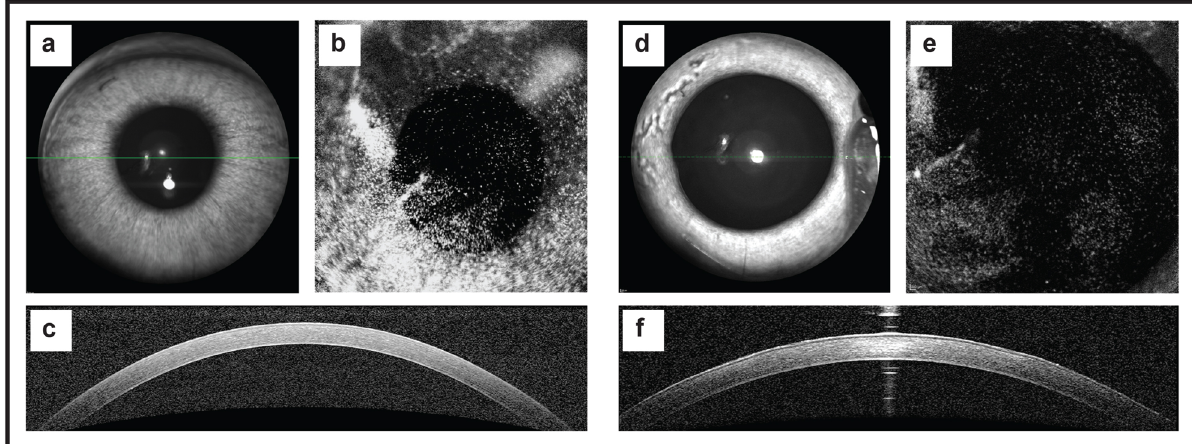
Figure 3. The effect of DIR on rabbit corneal endothelium following intracameral injection in vivo. DIR (final concentration 100 µg/ml) was injected into the anterior chamber of 3 rabbits to determine if this had any side- effects. ( a ) Photomicrograph of the rabbit anterior segment taken 1 day post DIR intracameral injection. The cornea remains transparent, with easy visualization of the iris details. ( b ) Infra-imaging using, the ICG filters on the Spectralis HRA, shows variable fluorescence across the endothelium, with speckled hyperfluorescent seen at areas of increased cellular dye uptake. ( c ) OCT image showing an optical cross-section of the central rabbit cornea. No increase in corneal thickness or inflammation is seen (CCT. Images from the same rabbit cornea taken on day 28 post DIR injection. ( d ) A photomicrograph of the rabbit anterior segment showing the cornea remains clear. ( e ) Infra-imaging using the ICG filters shows residual fluorescence at day 28, although maximal fluorescence intensity is reduced. ( f ) An OCT image taken at day 28 showing corneal thickness remains normal and unchanged throughout the study period (CCT 377